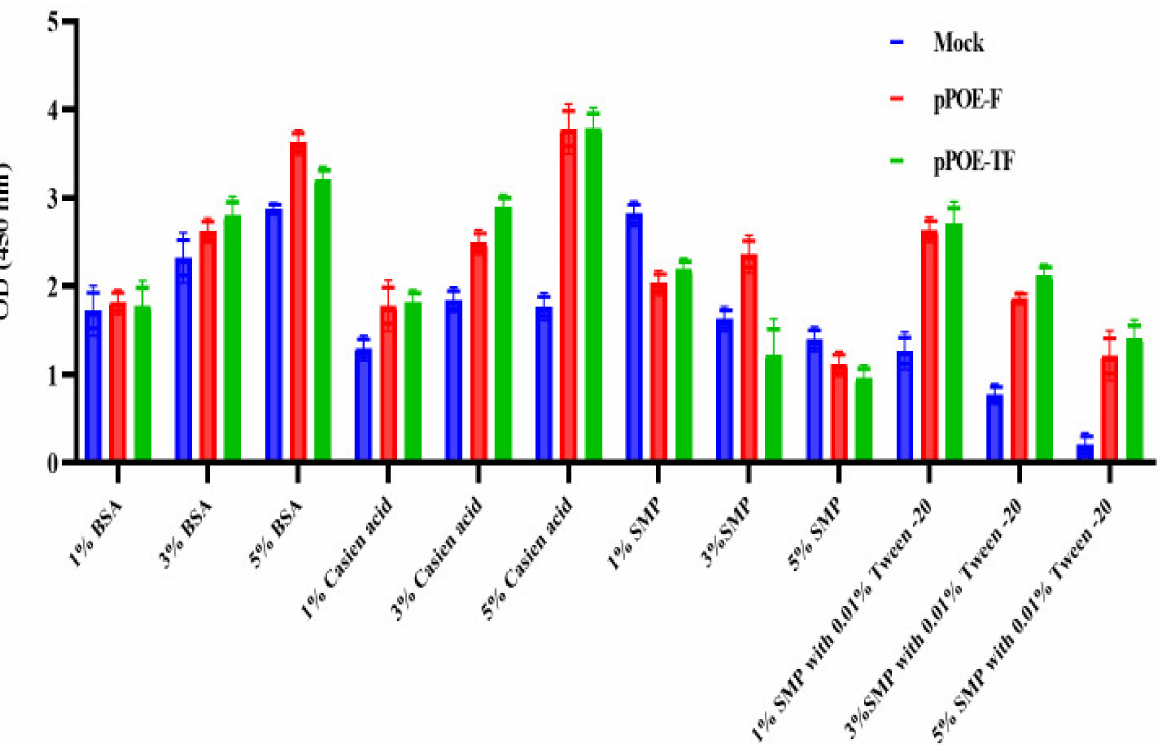
Figure 3. Graph showing optimum blocking buffer. The optimal dilution of each MPA was coated and blocked with different blocking buffers. Recombinant human orthopneumovirus F protein was added and detected by HRP-conjugated anti-RSV antibody in 1% blocking buffer. OD values are the mean of two independent experiments and bars represent means ± SD measured in each MPA. Differences between rats immunized with pPOE-F and pPOE-TF were statistically